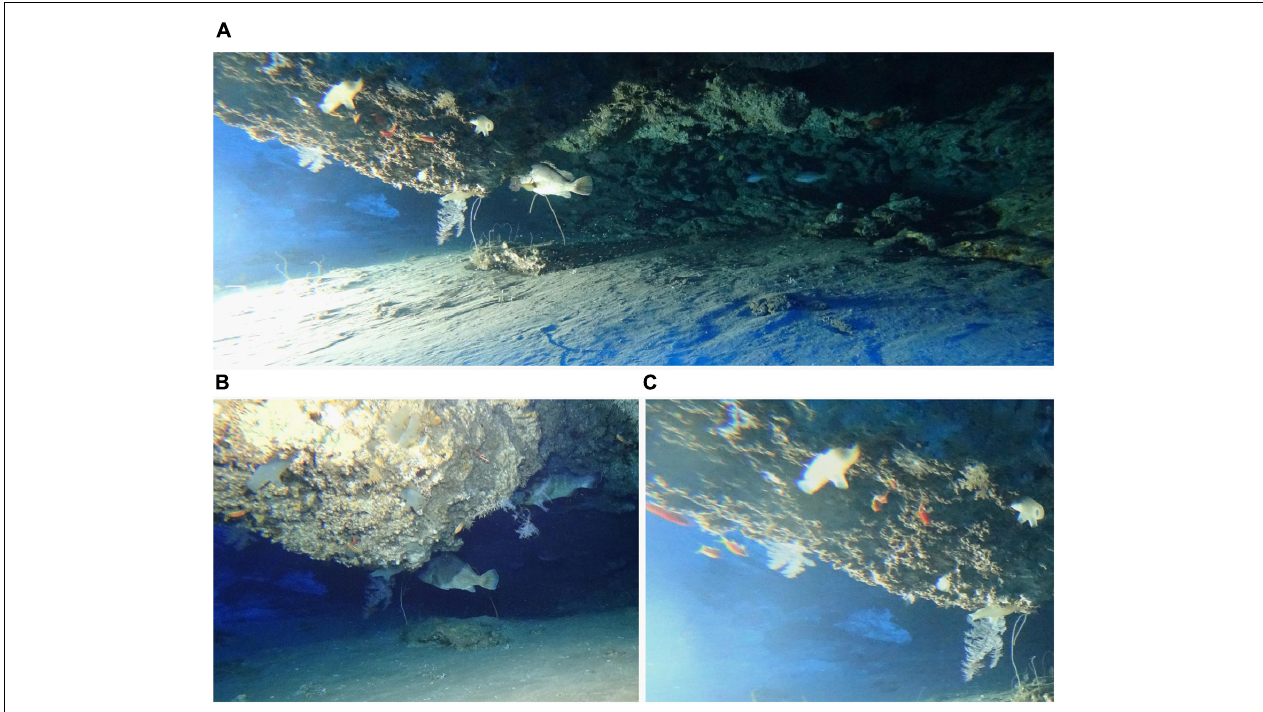
FIGURE 9 | Photographs of the cave where the coelacanth was video recorded as seen when divers were approaching to retrieve the cameras and oceanographic meters showing a grouper, Epinephelus sp. hiding near the ceiling of the rock overhang and small red fish resting on the ceiling on the left side (A) , groupers near the ceiling (B) , and a close-up image of the small orange and red colored fishes that reside on the surface of the underside of the cave, along with various invertebrates attached to the cave ceiling (C) .